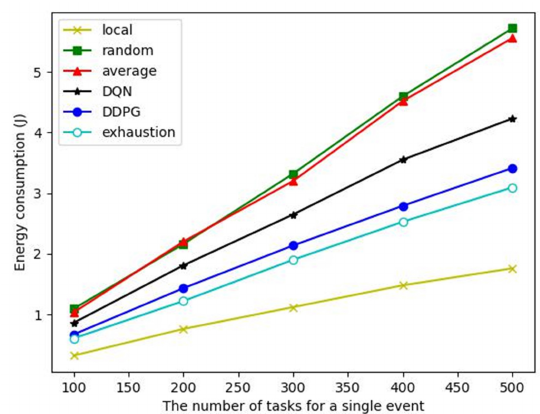
Figure 8. Energy consumption for a different number of tasks in an event. Table 5. Comparison of the reaction time of tasks, task completion rate, and energy consumption.